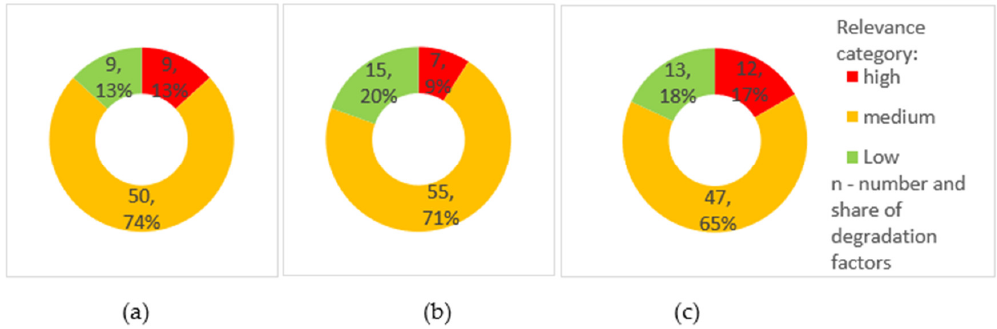
Figure 7. Number and share of degradation factors in risk categories for ( a ) simulation 1, ( b ) simulation 2, and ( c ) simulation 3.